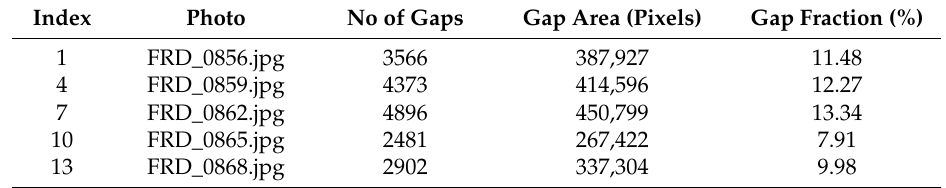
Table 2. Sample estimate of gap fraction at 5 points in a plot using a cropped circular area ≈ 3,378,360